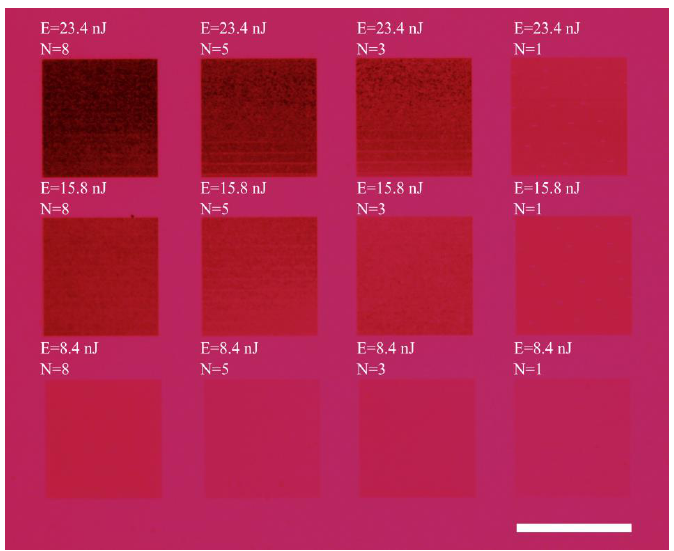
Figure 1 . Optical image of GaSe surface with an ARM, inscribed at Е = 8.4, 15.8 and 23.4 nJ (bottom, middle, and top row consequently), and numbers of pulses: N = 1, 3, 5, and 8. The scale bar has a length of 300 µm.